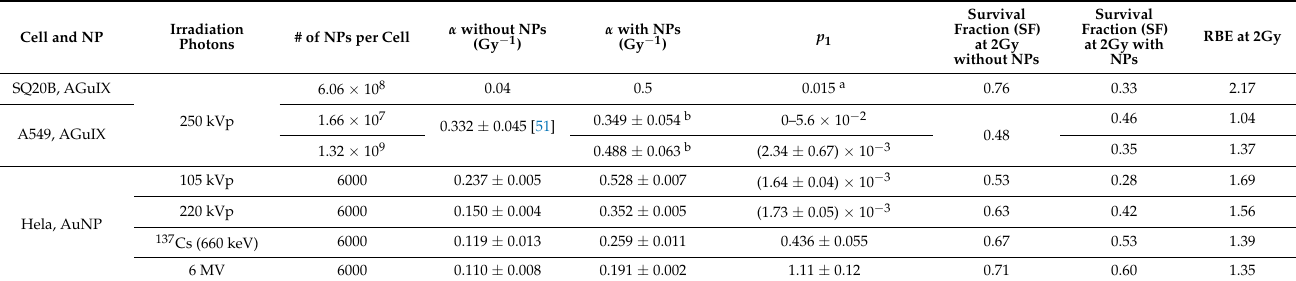
Table 3. Bomb model parameters for the cell irradiation with photon